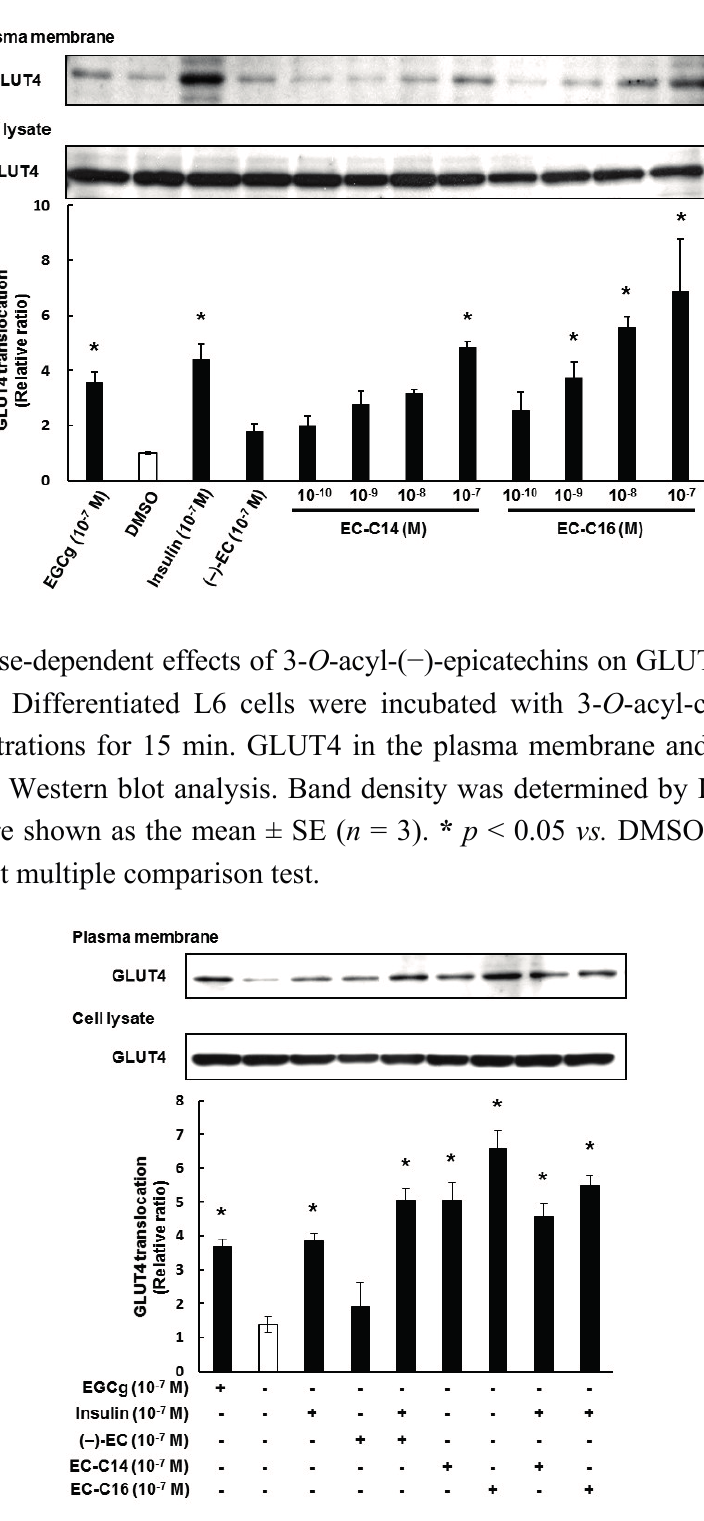
Figure 5. The effects of 3- O -acyl-( − )-epicatechins on GLUT4 translocation in the presence of insulin in L6 myotubes. Differentiated L6 cells were incubated with 3- O -acyl-( − )-epicatechins at 100 nM in the presence and absence of insulin at 100 nM for 15 min. GLUT4 in the plasma membrane and the cell lysate were detected by Western blot analysis. Band density was determined by ImageJ analysis software. Data are shown as the mean ± SE ( n = 3). * p < 0.05 vs. DMSO-treated control cells by a Dunnett multiple comparison